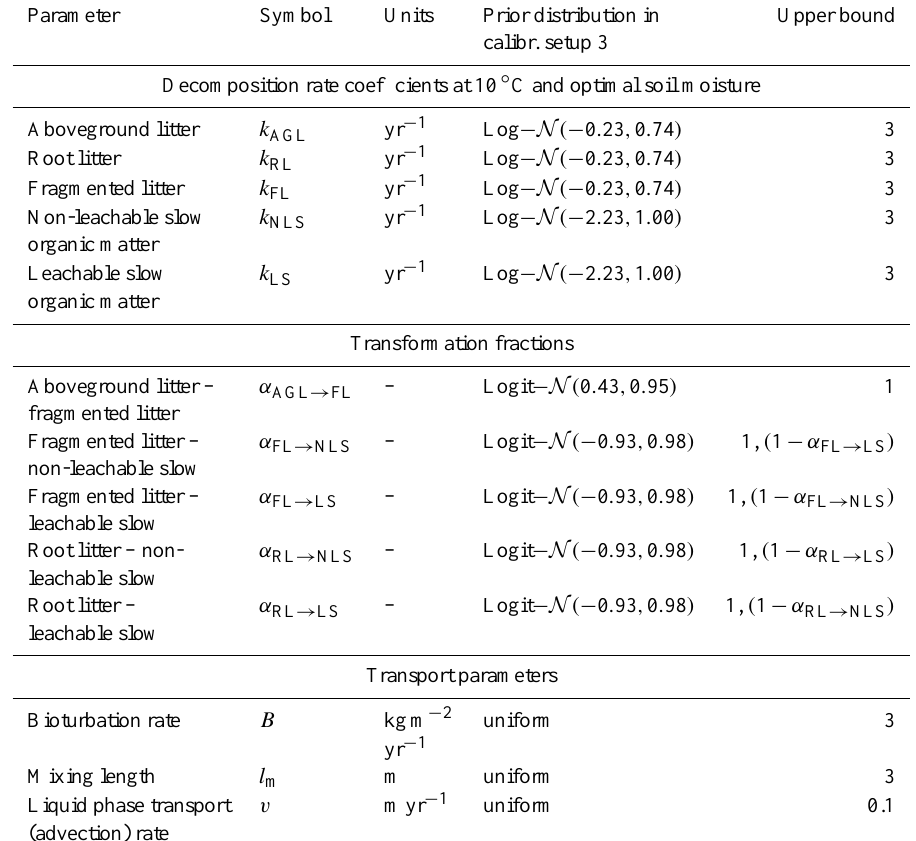
Table 2. The model parameters estimated in the calibration. Note that the prior distributions were only used for calibration setup 3. The lower bound for all parameters is zero; the upper bound is given in the